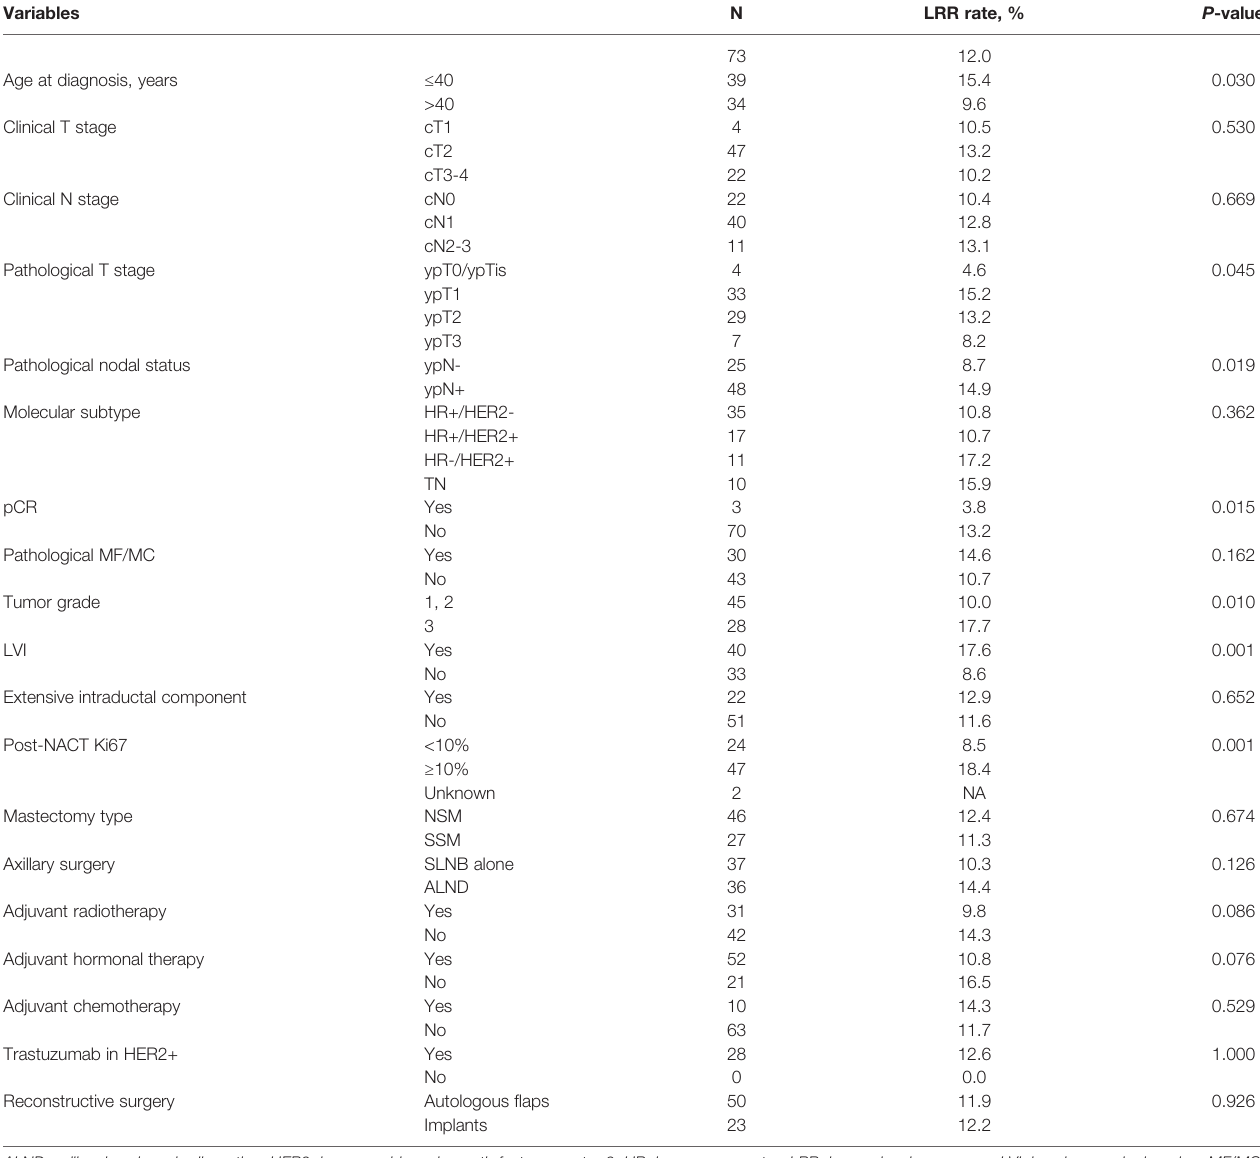
TABLE 3 | Univariate analysis of factors associated with LRR.